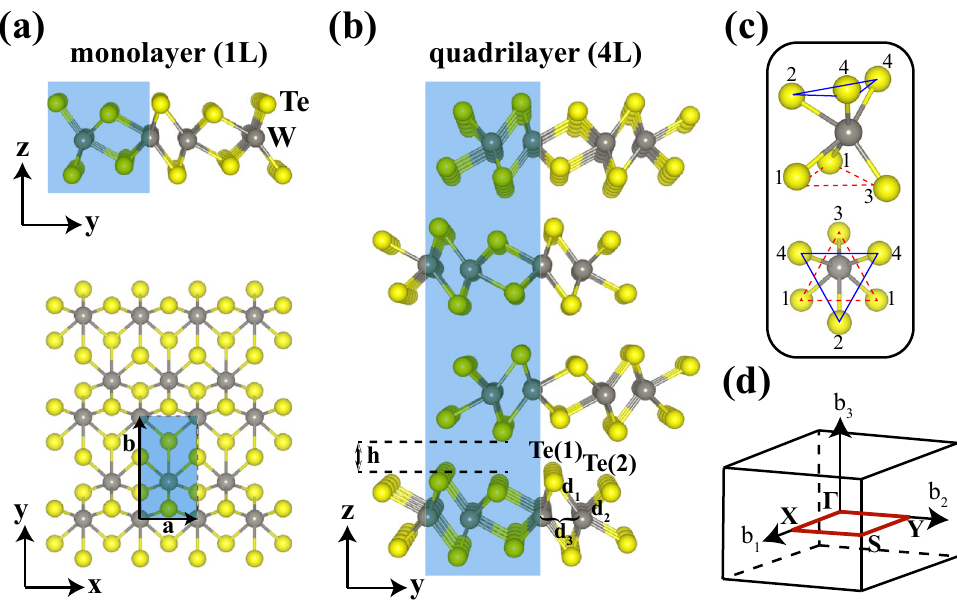
Figure 1. Optimized crystal structures with ( a ) side view ( yz -plane) and top view ( xy -plane) of monolayer (1L) and ( b ) side view of quadrilayer (4L) 1T ′ WTe 2 . The rectangular unit cells are shown by the blue-shaded areas omitting the vacuum distance in the z -direction. ( c ) Distorted octahedral geometry formed by one W and six Te atoms with two different views, where pairs of rotated triangles are indicated with blue-solid and red-dashed lines. ( d ) 3D orthorhombic Brillouin zone (BZ), in which the 2D BZ is indicated by the red-rectangle with corresponding high symmetry points, i.e. Ŵ , X, S, Y.